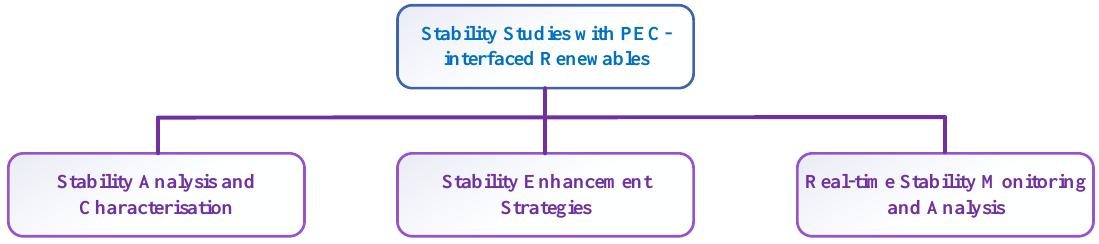
Figure 2. Categorization of stability studies conducted with power electronic converter (PEC)-interfaced renewables.